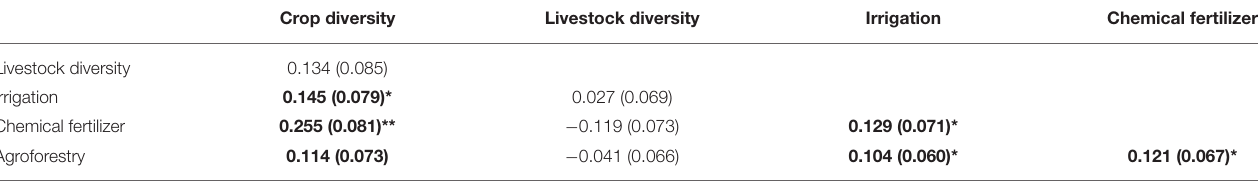
TABLE 4 | Correlation coefficients for MVP regression equations (standard errors in